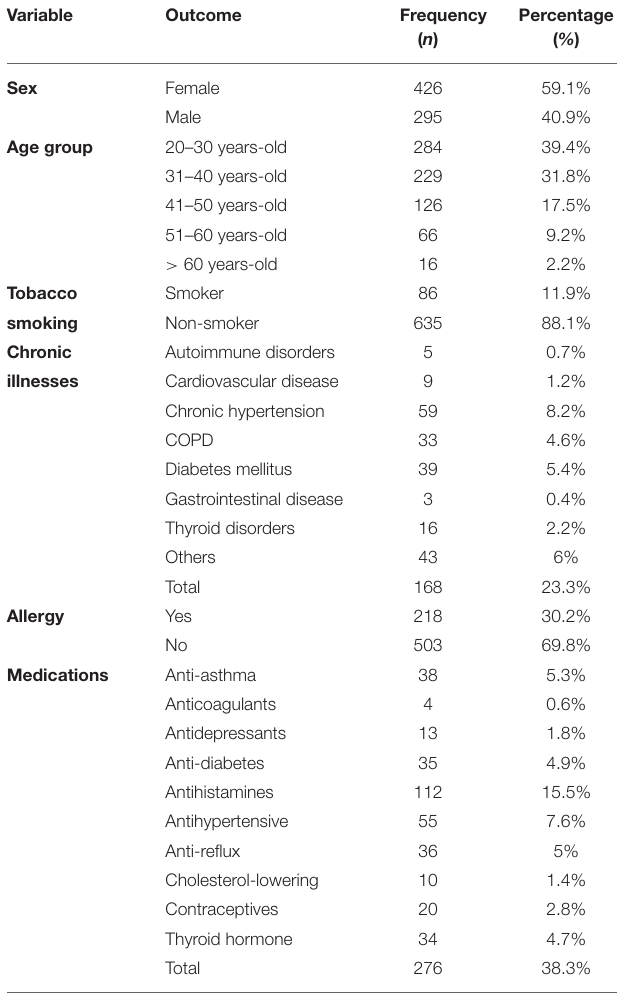
TABLE 1 | Demographic and anamnestic characteristics of Algerian healthcare workers receiving COVID-19 vaccines ( n =